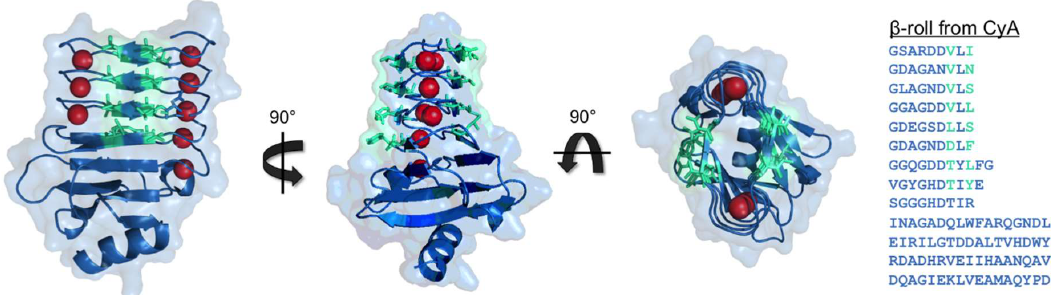
Figure 1. The β-roll from adenylate cyclase (CyA) of B. pertussis . The peptide structure is shown in the folded conformation bound to calcium ions (red) (PDB file: 5CVW). The residues forming the β-sheet faces are highlighted in turquoise in the amino acids sequence on the right. The figures were rendered in PyMOL.